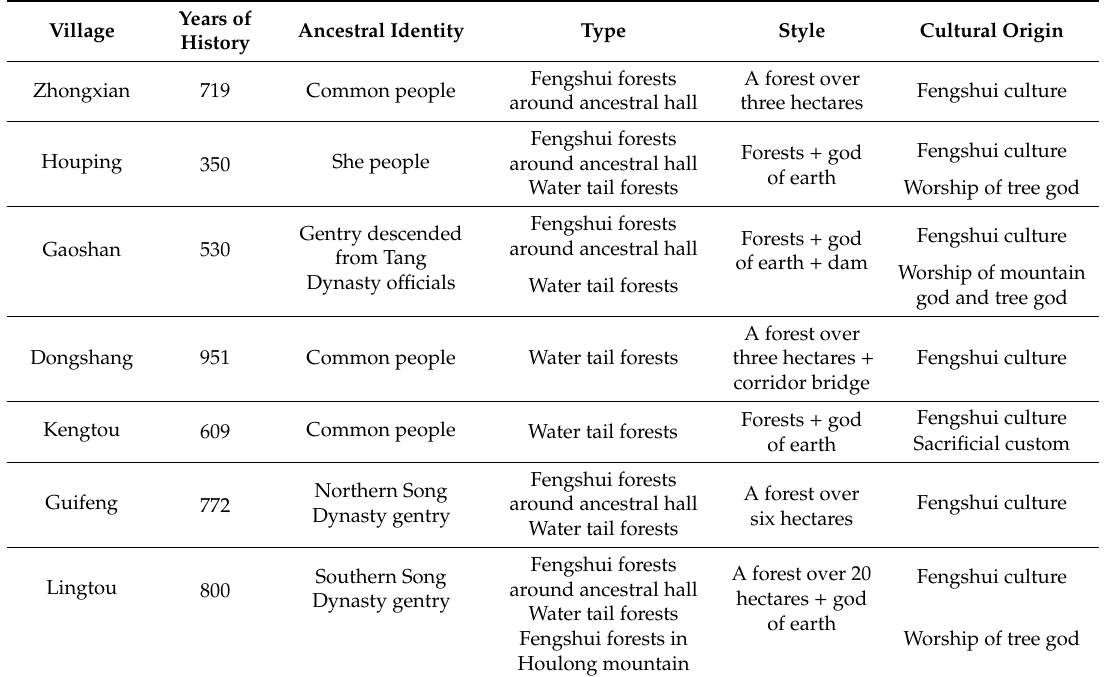
Figure 1. Distribution of the seven villages. Note: △ , ○ , ◇ , □ , ☆ , ¤ and ◎ represent Guifeng, Zhongxian, Houping, Gaoshan, Kengtou, Dongshang, and Lingtou villages, respectively; ‘FJ’ represents Fujian Province, and ‘JX’ represents Jiangxi Province. Table 1. Types of fengshui forests at the survey sites.